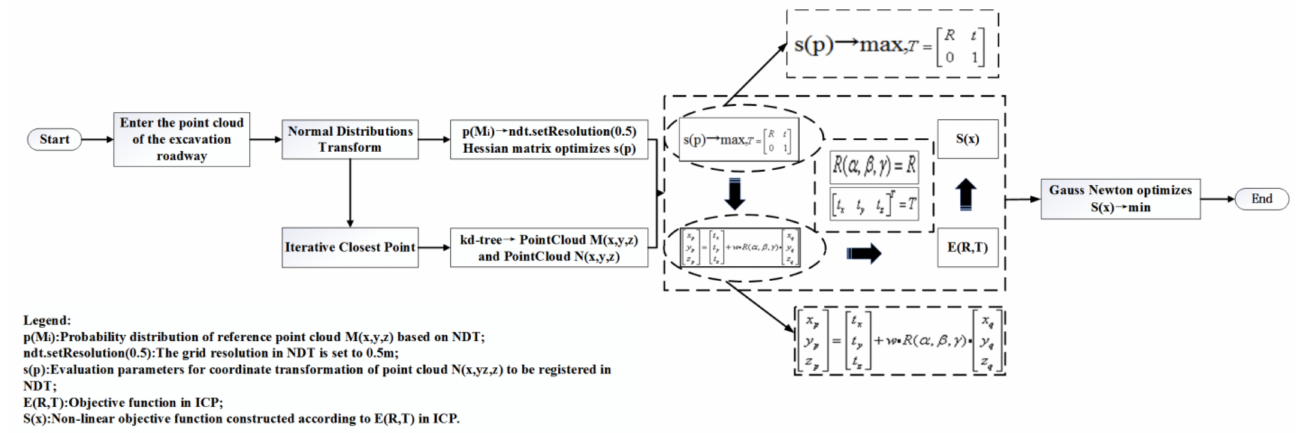
Figure 7. The 3D NDT-ICP algorithm